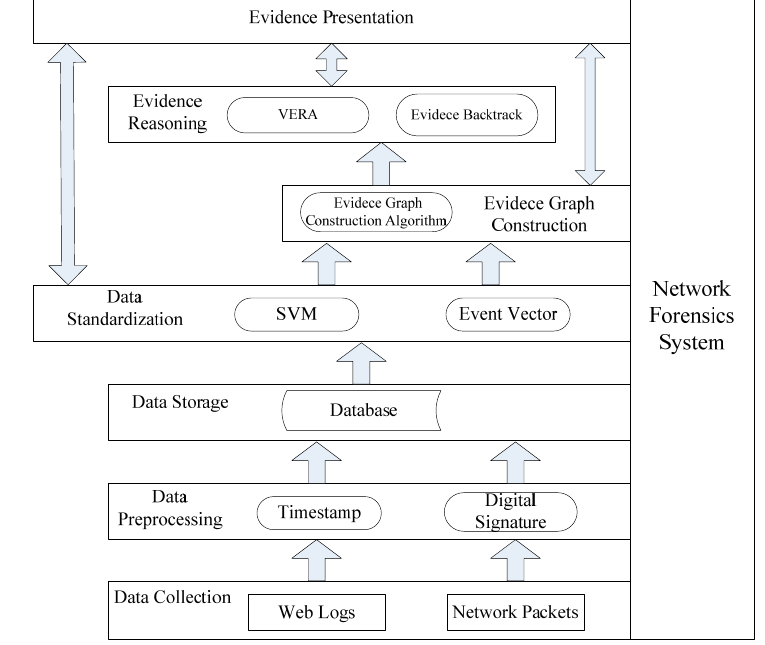
Figure 1. A Framework for Network Forensics